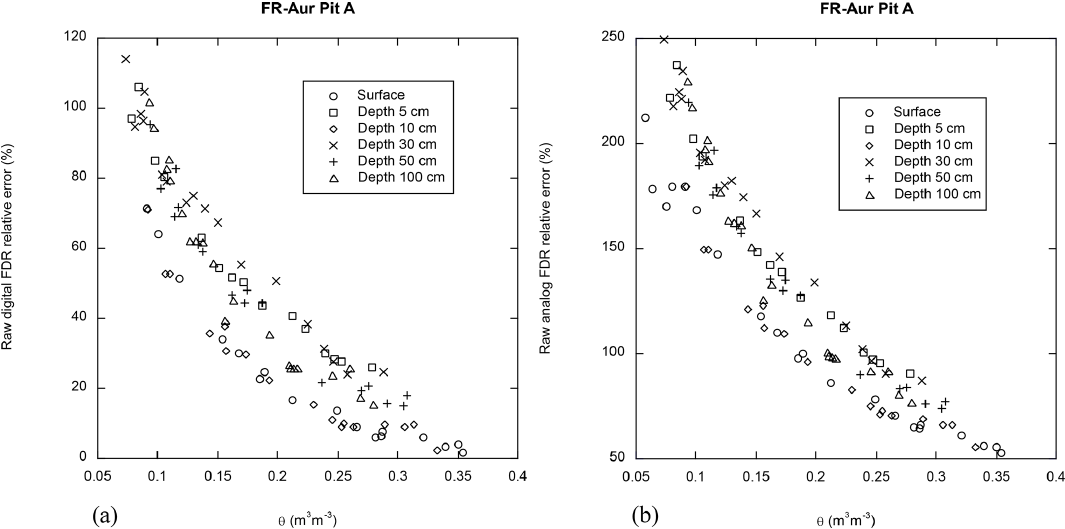
Figure 6. Relative error of SWC estimated with (a) a factory-calibrated digital sensor based on the real part of the dielectric permittivity or (b) a factory-calibrated analog sensor based on the modulus of the dielectric permittivity, versus real SWC into pit A at six